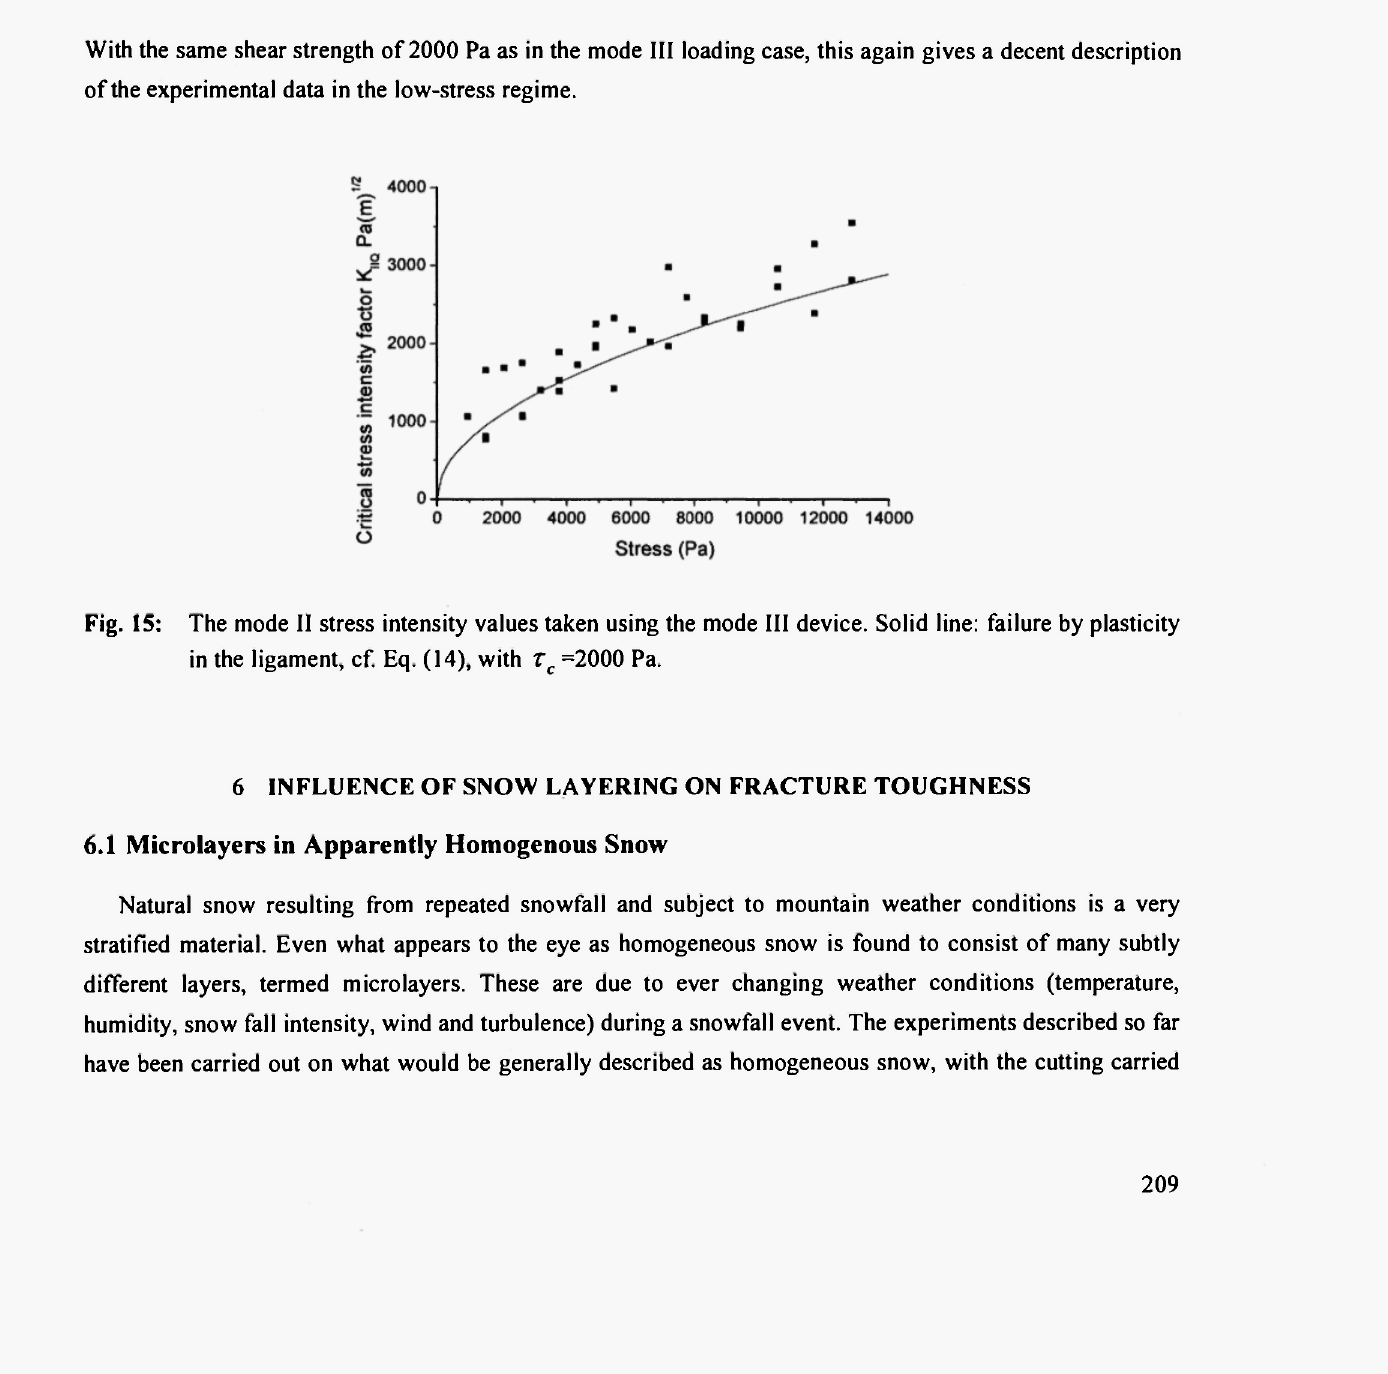
The mode II stress intensity values taken using the mode III device. Solid line: failure by plasticity in the ligament, cf. Eq. (14), with T c =2000